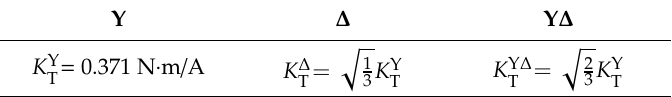
Figure 5. Electromagnetic torque vs. rotor position: ( a ) numerical calculations; ( b ) measurements. Table 1. Torque constants for the analysed configurations.